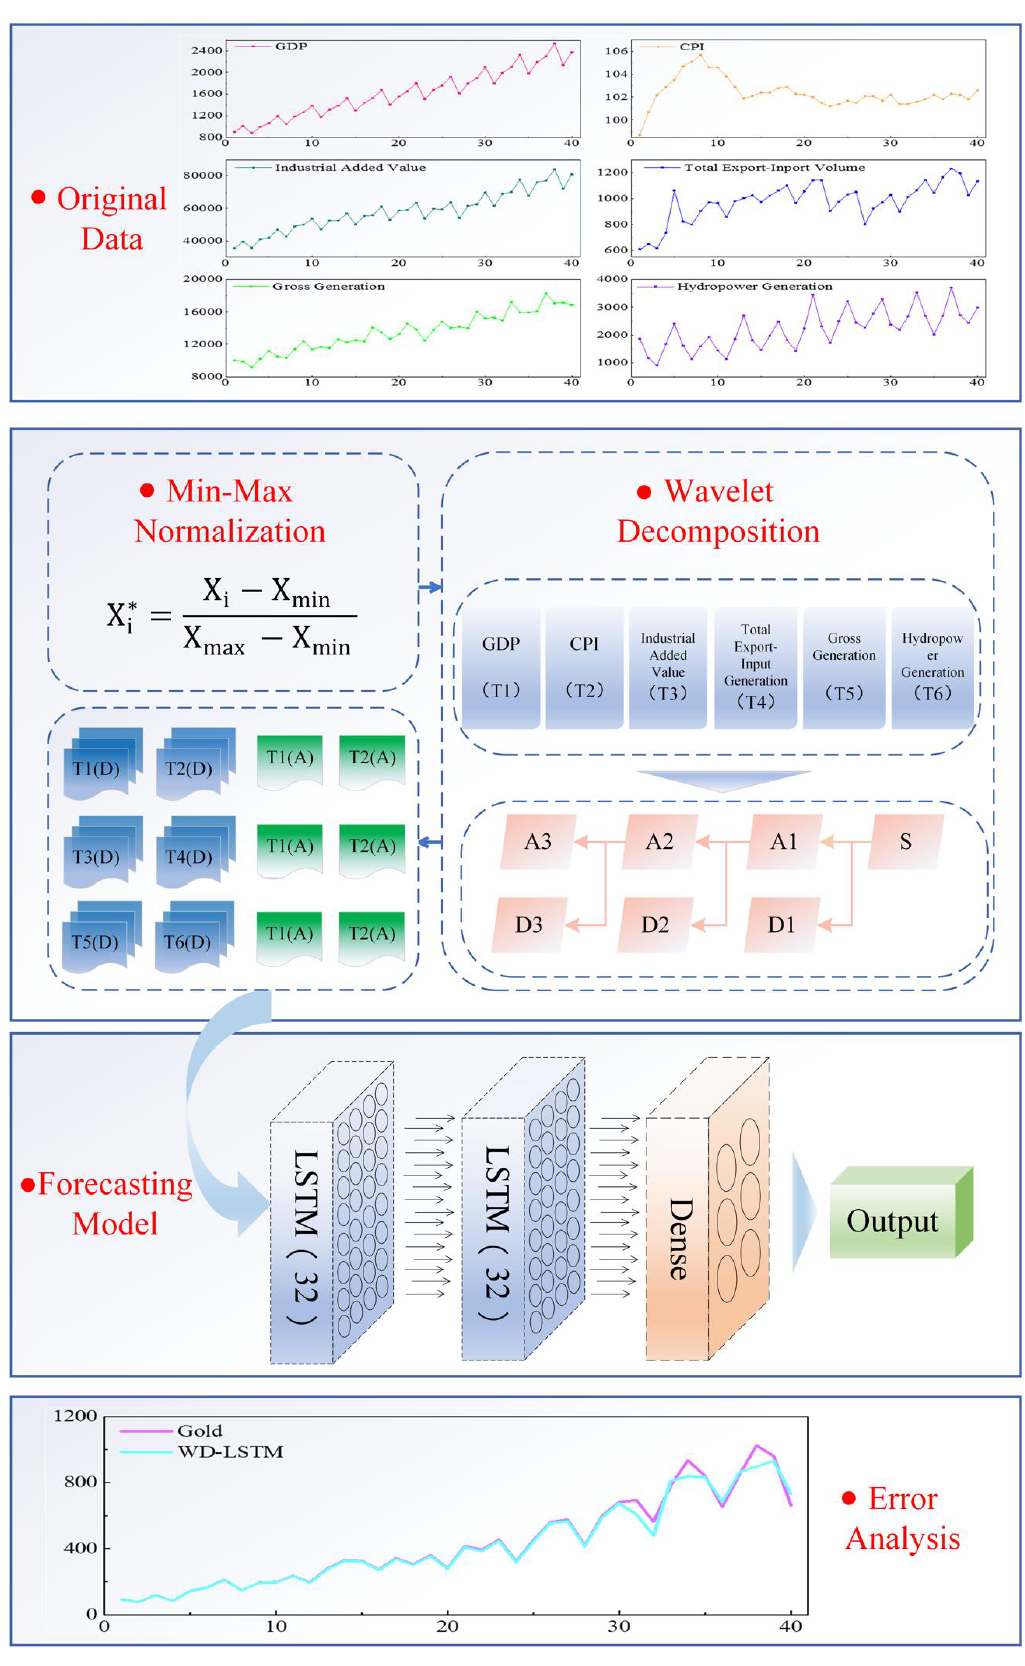
Figure 1. Calculation process of the WD-LSTM model.